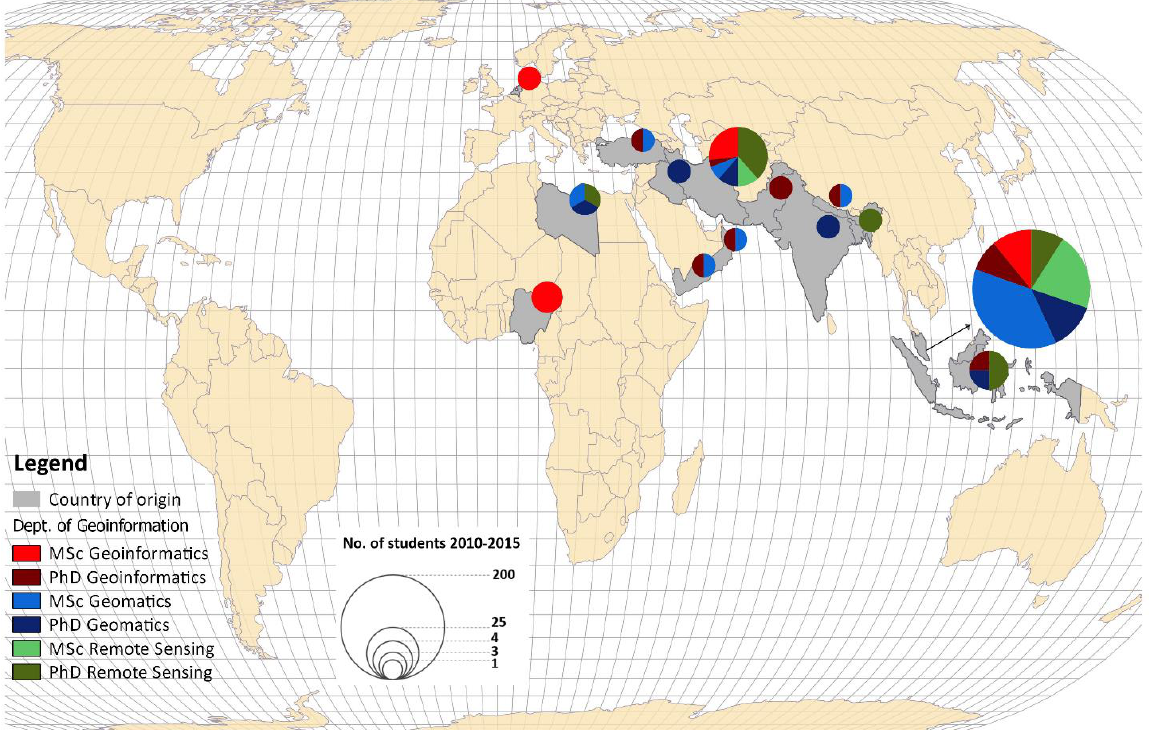
Figure 1. FGHT-Postgraduate statistics 2010-2015 (number of students according to their country of origin and programmes